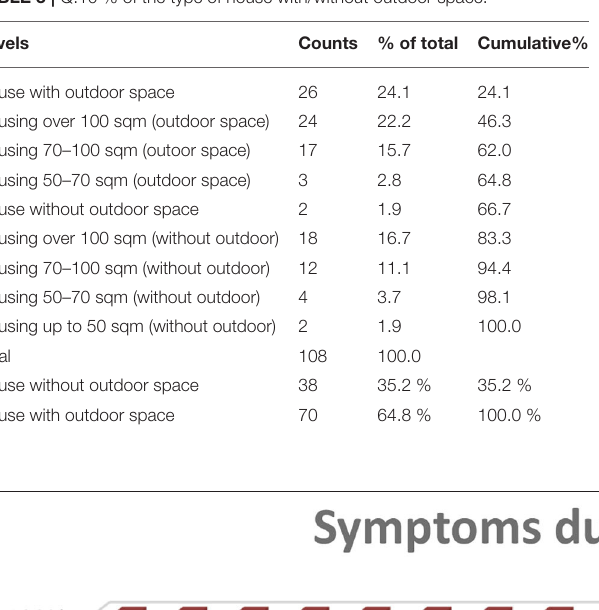
TABLE 3 | Q.10 % of the type of house with/without outdoor space.